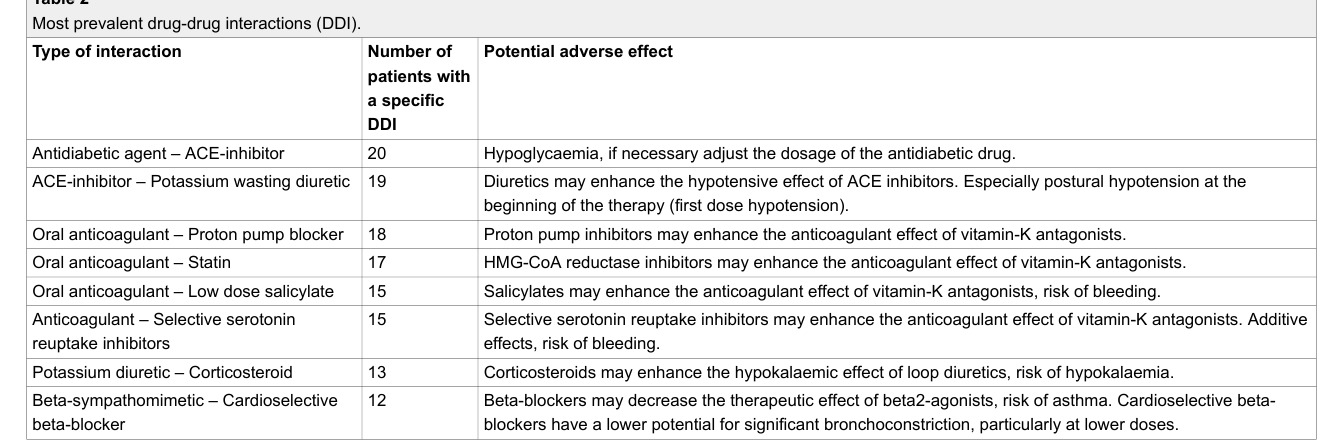
Table 2 Most prevalent drug-drug interactions